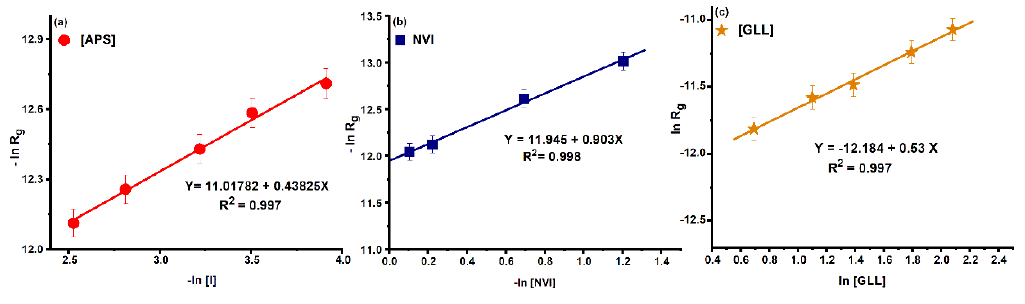
Figure 4. Plotting ln R g versus ( a ) ln [ I ]; ( b ) ln [ NVI ]; and ( c ) ln [ GLL ].